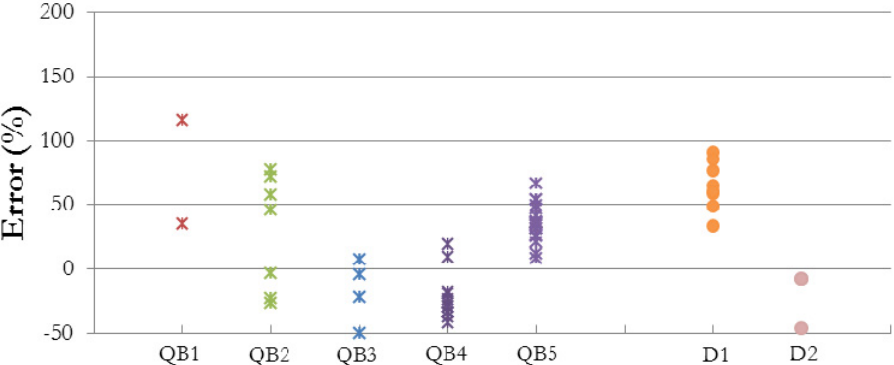
Figure 4: Error results using Von Mises Equivalent Stress as effective stress for Quasi-Brittle and Ductile materials.